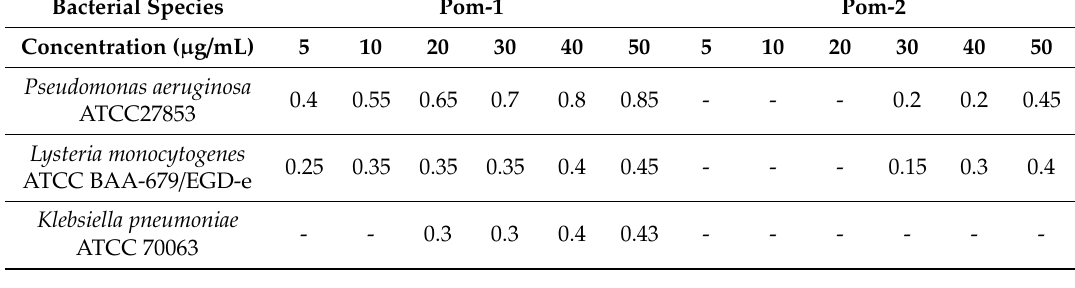
Table 4. Values of the 50% cytotoxic concentration (CC 50 ), half maximal inhibitory concentration (IC 50 ) and selectivity index (SI).